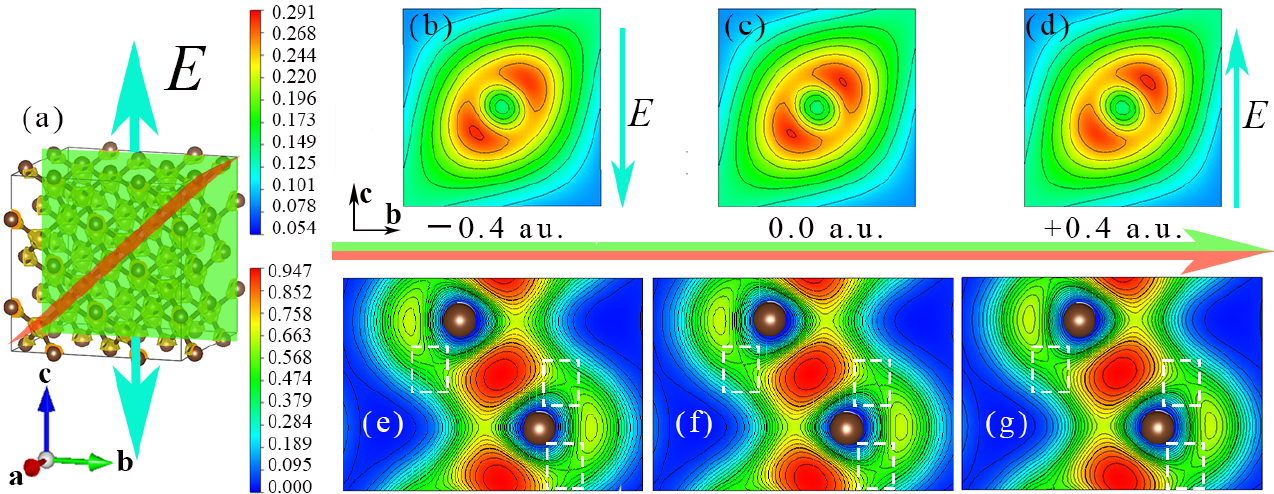
Figure 8. Charge density and electron localization function (ELF) of diamond under external electric field. ( a ) The picture shows the diamond 2 × 2 × 2 supercell model and the schematic diagram of the electric field direction, in which the grass green section and the orange section are the 2D charge density section and the 2D electron local function section, respectively. The ( b – d ) plots represent the C atomic charge densities at electric field strengths of −0.4 a.u., 0.0 a.u. and +0.4 a.u., respectively. The ( e – g ) show the charge transfer around C−C bonds at electric field strengths of −0.4 a.u., 0.0 a.u. and +0.4 a.u., respectively.